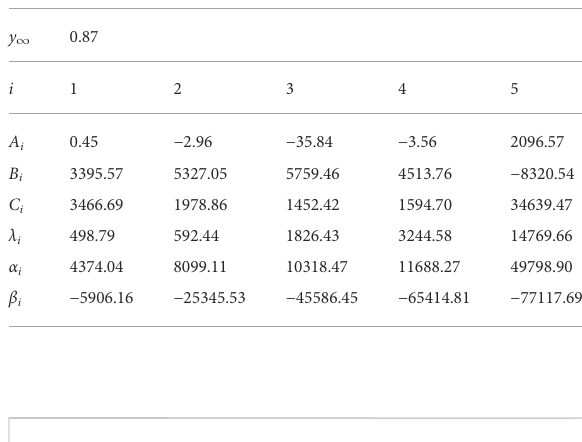
TABLE 4 Parameters y ∞ , A i , B i , C i , λ i , α i , and β i for GW32K. The parameters were fi tted at 10 Hz — 10 kHz.